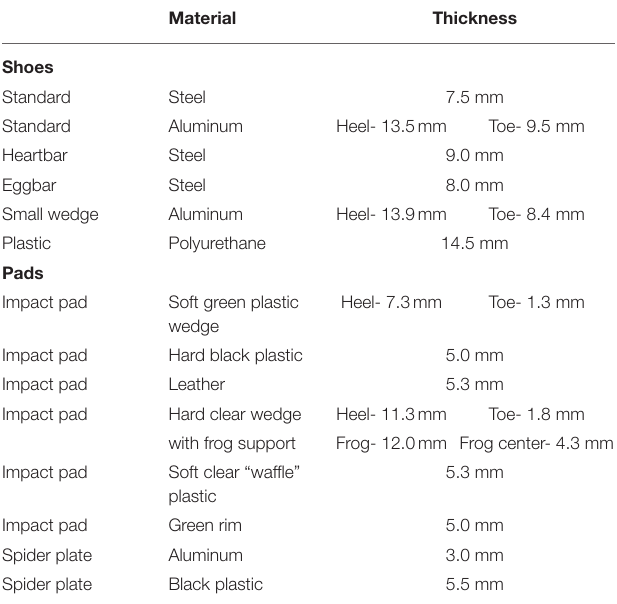
TABLE 2 | Shoe and Pad Materials and